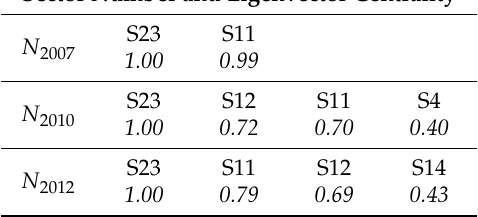
Table 5. Sectors with relatively large eigenvector centrality